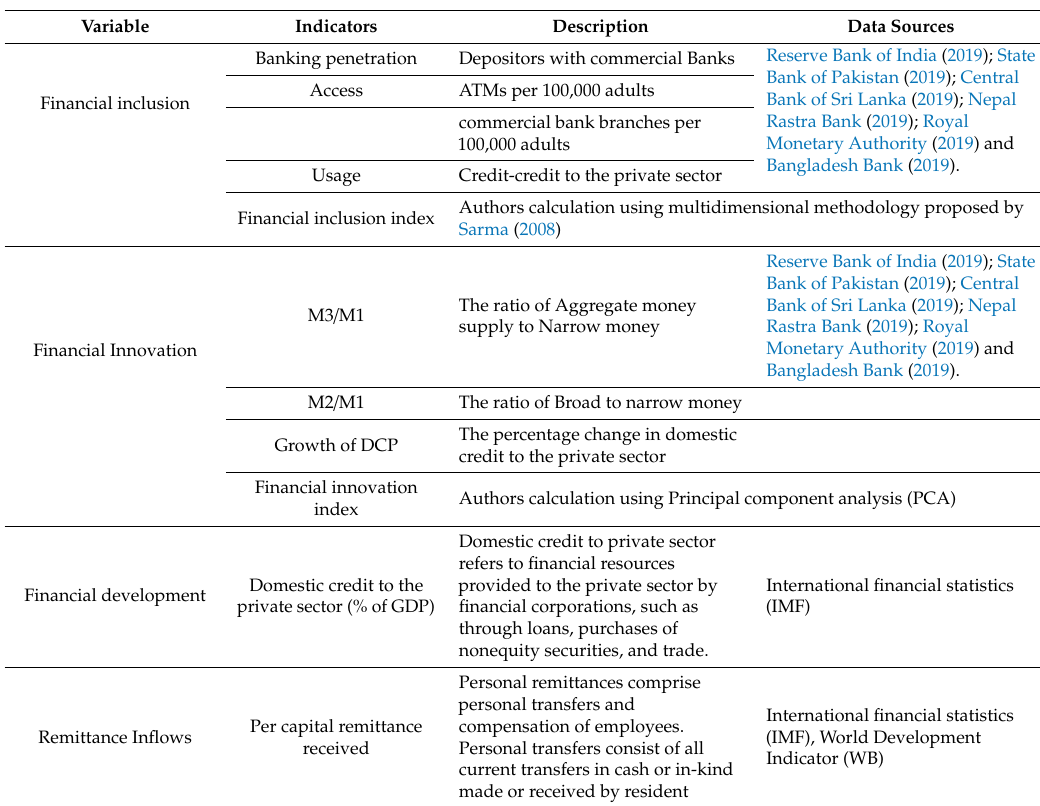
Table A3. Variables Descriptions and